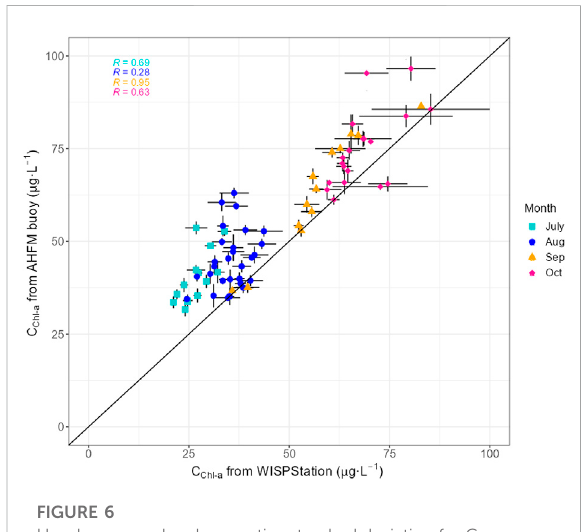
FIGURE 6 Hourly averaged and respective standard deviation for C Chl-a derived from fl uorescence ( y -axis) and C Chl-a derived from the spectral WISPStation data ( x -axis) in Võrtsjärv during July-October 2018. Different months are coded with different colours. Time GMT+3 is